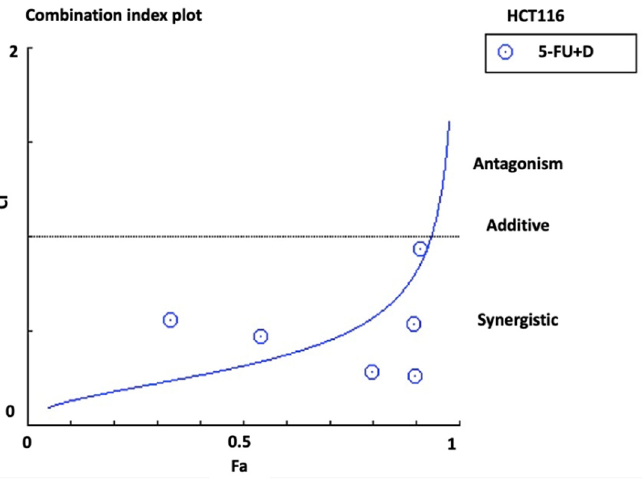
Figure 5. Combination index plot (Fa-CI plot) of interaction between 5-FU and diosmetin (D) in HCT116 cells generated by CompuSyn software. Fa: inhibitory effect, CI: combination index. Fa of 0.5 represents 50% growth inhibition.